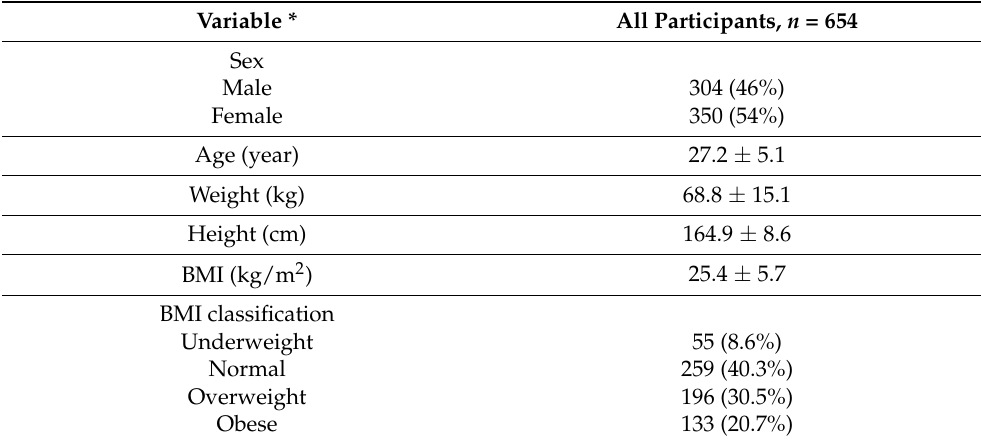
Table 1. Sociodemographic and anthropometric characteristics of the study